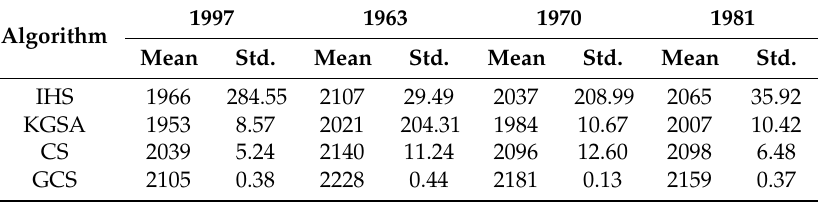
Figure 9. Streamflow of Pingshan station in normal years. Table 5. Comparison of power generation (10 8 kWh) in normal years.